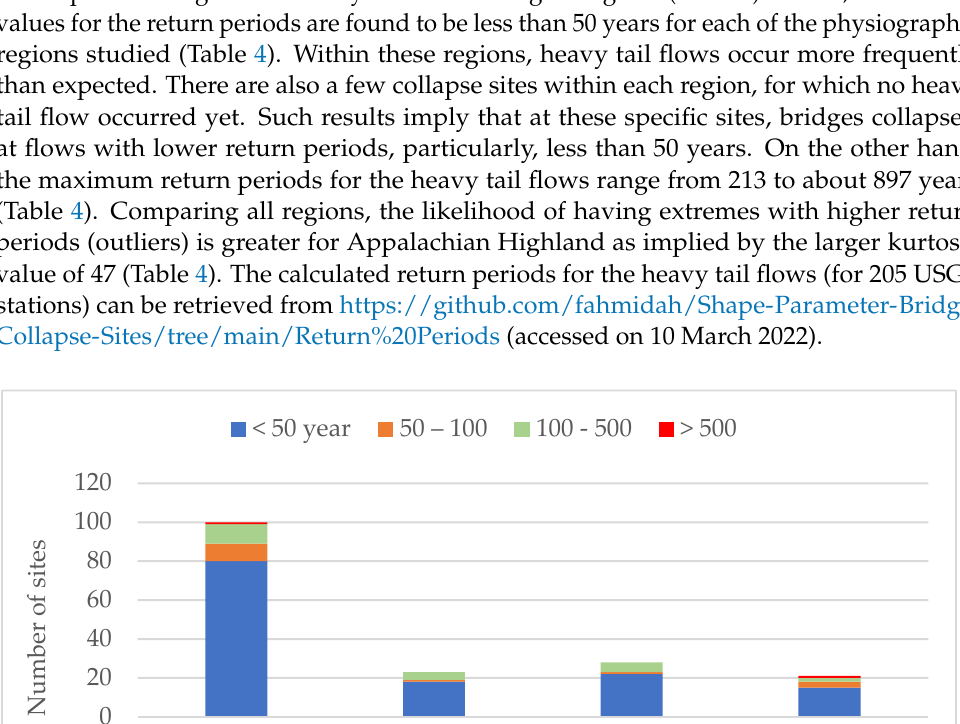
Figure 14. Number of sites with heavy and light tail flows of the bridge collapse sites across different regions.